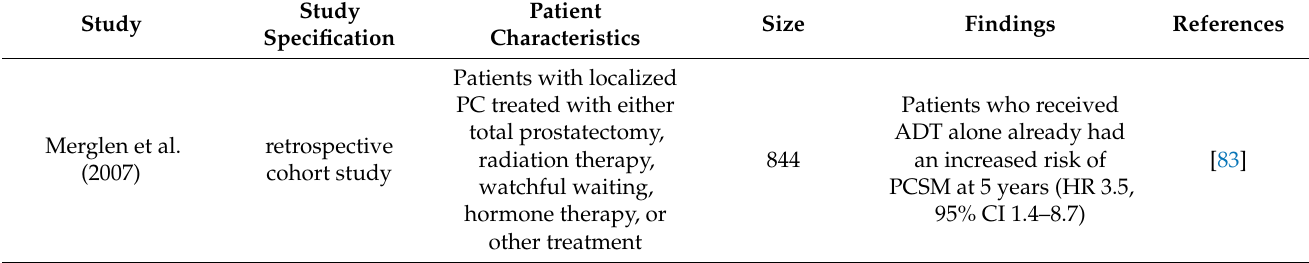
Table 2. Negative data of ADT for high-risk localized and locally advanced prostate